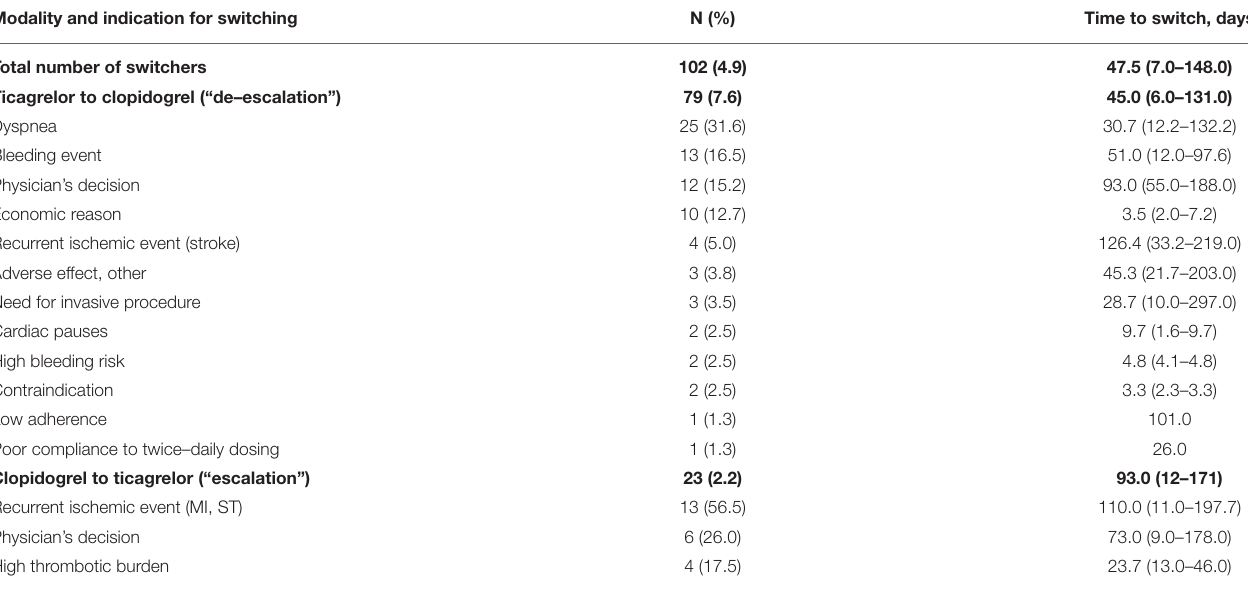
TABLE 3 | Reasons for and timing of P2Y 12 inhibitor